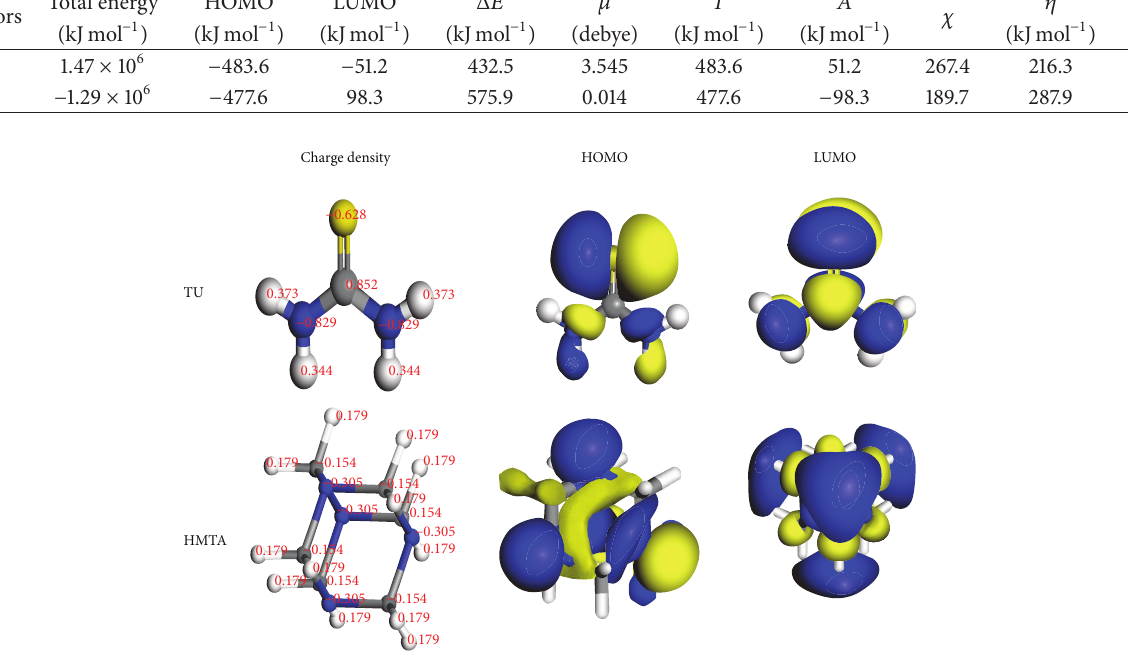
Figure 7: The optimized structures and molecular orbital plots for